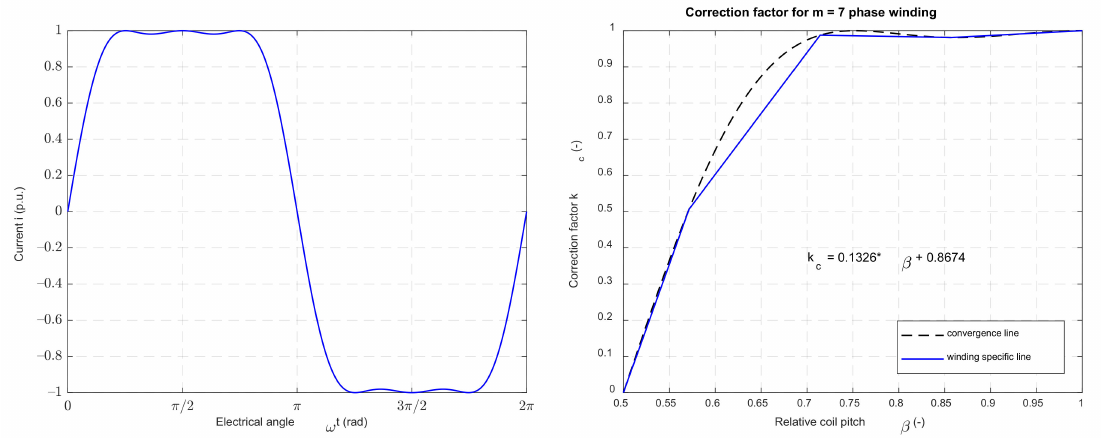
Figure 7. Waveform of current with injected third and fifth harmonic components and the correction factor, k c , of seven- phase